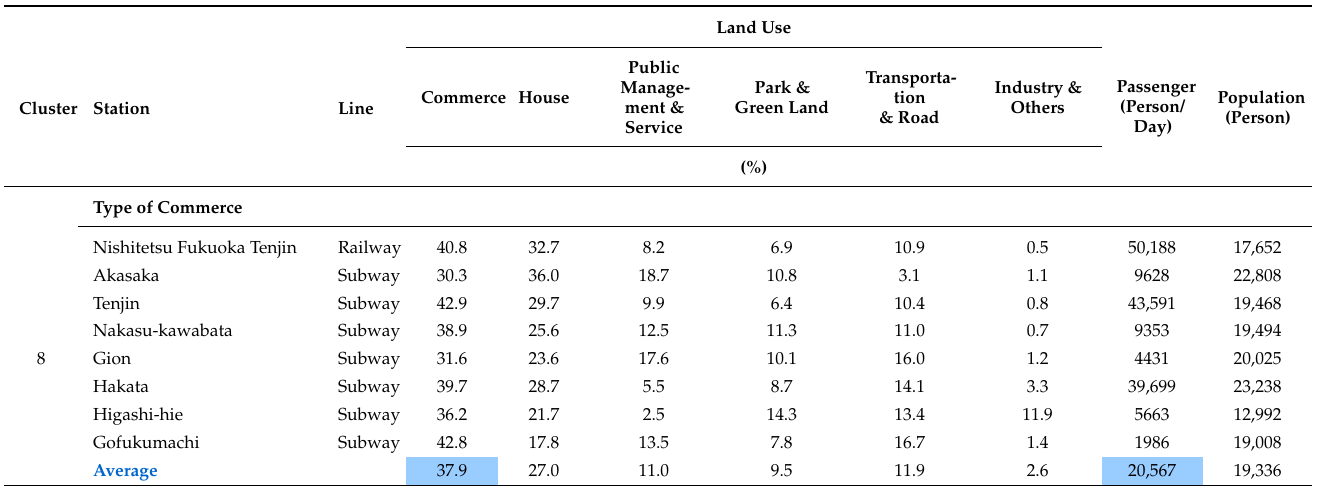
Table 12. Result of cluster analysis of 400–800 m radius (including land use, population, and